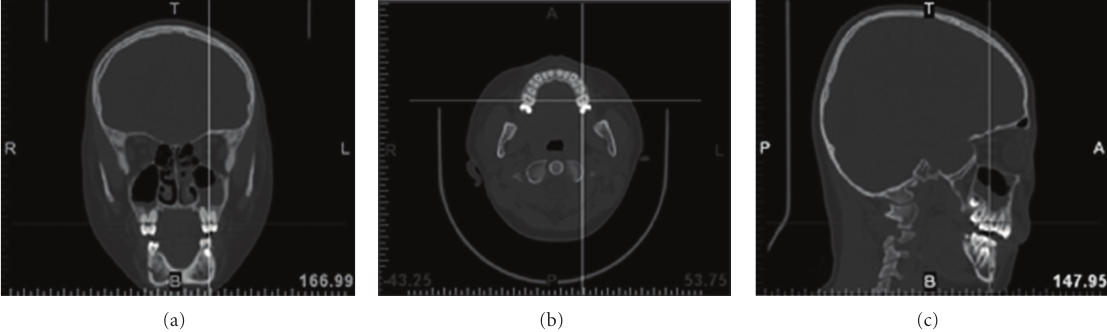
Figure 3: Orientation parameters registration, top T, bottom B, left L, right R, anterior A, and posterior P, for (a) front view images; (b) top view images, and (c) side view